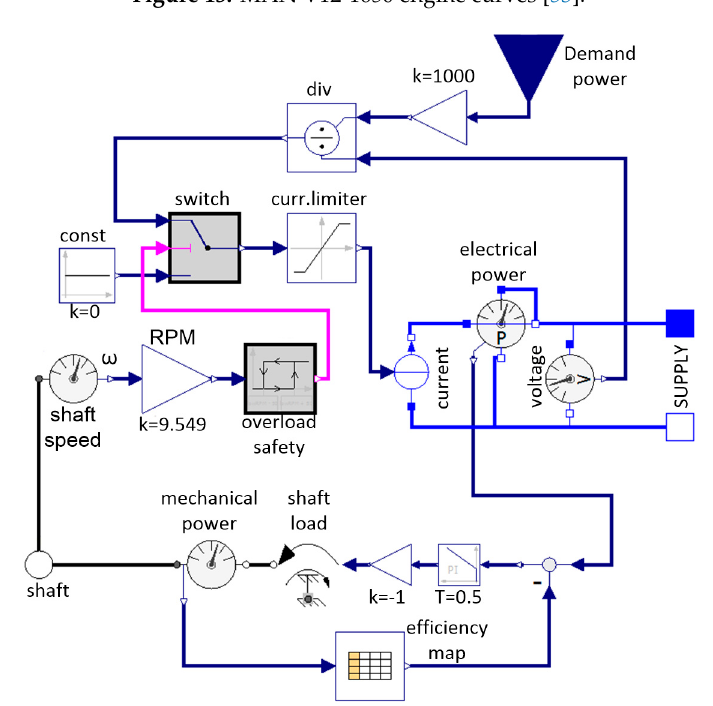
Figure 13. MAN V12-1650 engine curves [53].